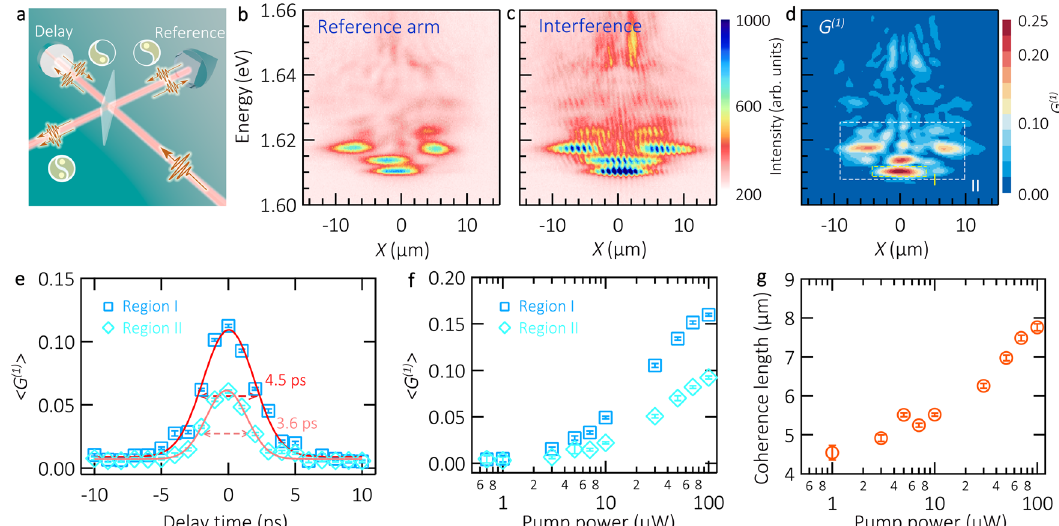
Fig. 4 First order autocorrelation measurement of room temperature exciton-polaritons. a Sketch of the Michelson interferometer, containing a retrore fl ector in the reference arm ( fi xed position, providing a vertical and horizontal image mirroring) and a fl at mirror in the delay arm (mounted on a motorized translation stage). The “ yin and yang ” symbols represent, schematically, the two interfering images. b PL distribution of polaritons as a function of energy and real space (see the resolved X slice in Fig. 1b), recorded from the reference arm of Michelson interferometer. c Corresponding interference image at zero delay time between reference and delay arms. Intensity is encoded in a false color scale. The acquisition time for each image is 120 s. d Corresponding fi rst order correlation function G (1) encoded in a false color scale. e Delay-time dependence of 〈 G (1) 〉 , the data points are the result of averaging G (1) in regions I and II (dashed boxes in panel d ), displayed as squares and diamonds, respectively. The data is fi tted with a Gaussian function, indicating the corresponding temporal FWHM. The pump power is 90 μ W in panels b – e . f 〈 G (1) 〉 as a function of pump power. The square (diamond) data points correspond to region I (II). In panels e and f the error bars are obtained by comparing the polariton G (1) signal to the standard deviation of the background G (1) noise. g Coherence length λ c in region I as a function of pump power, the error bars correspond to the 95% con fi dence interval of the Gaussian fi tting from the G (1) (x) spatial shape of the polariton